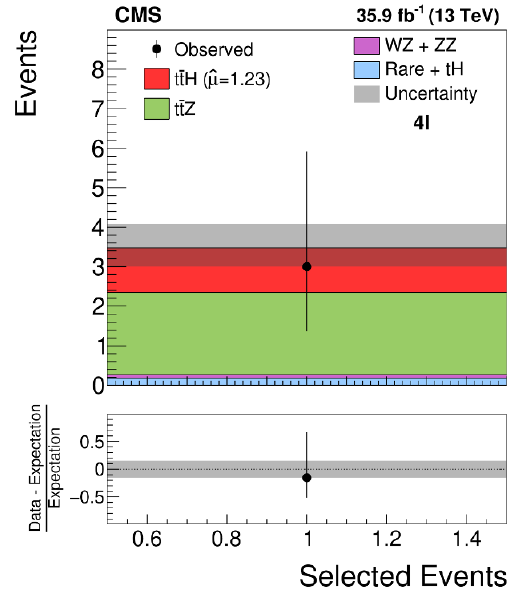
Figure 4 . Number of events observed and expected in the 4 ‘ category. The distributions expected for signal and background processes are shown for the values of nuisance parameters obtained from the combined ML (cid:12)t and (cid:22) = ^ (cid:22) = 1 : 23, corresponding to the best-(cid:12)t value from the ML (cid:12)t.